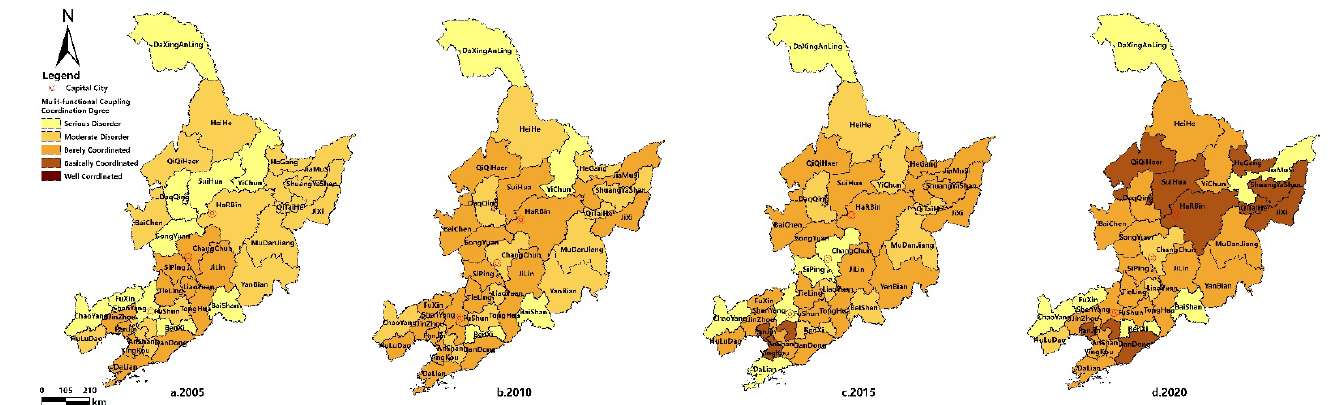
Figure 5. Spatial-temporal evolution of multifunctional coupling coordination degree of cultivated land in 2005, 2010, 2015, and 2020.